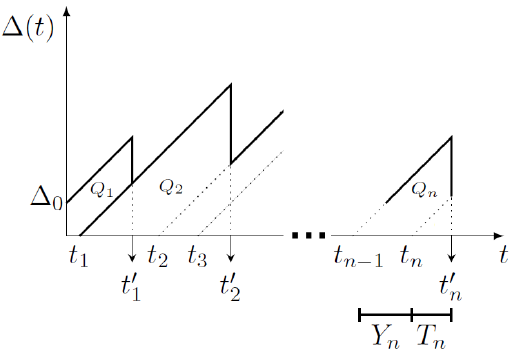
Figure 2. The progression of AoI in our